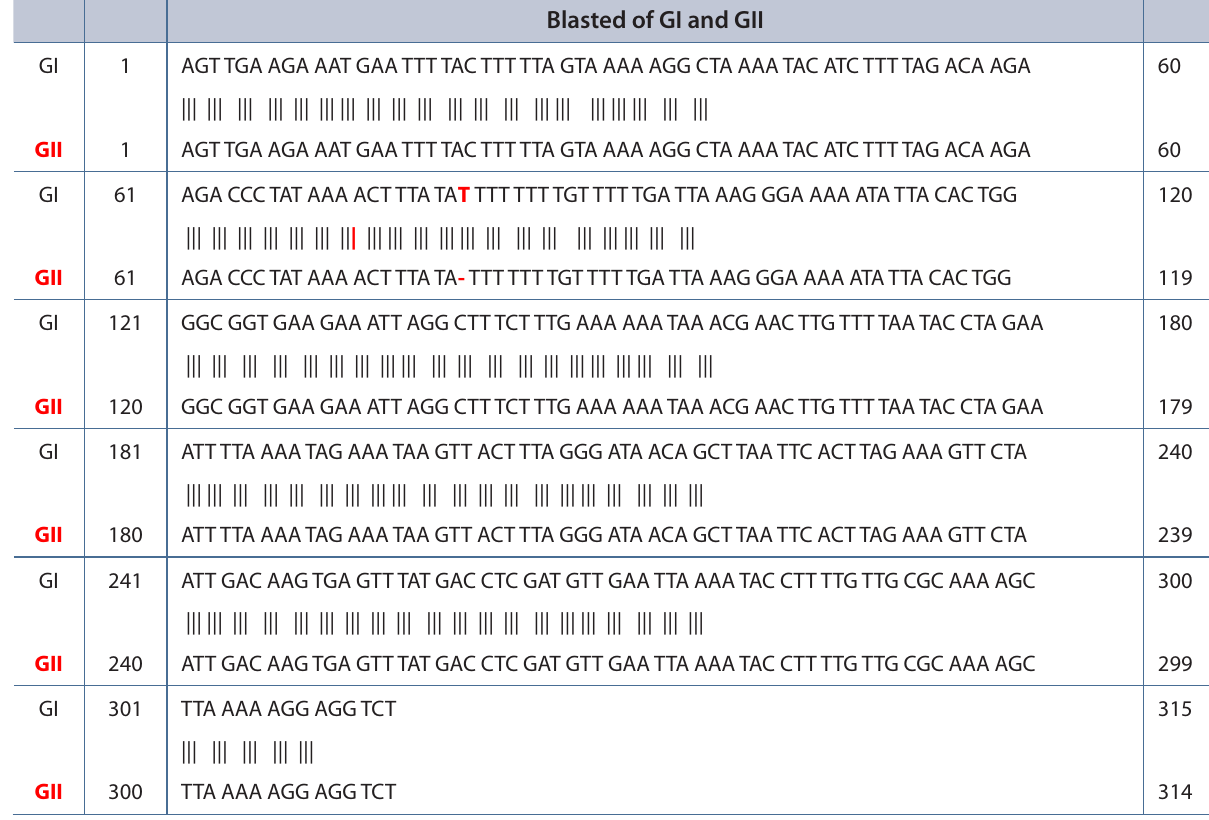
Blasted of GI and